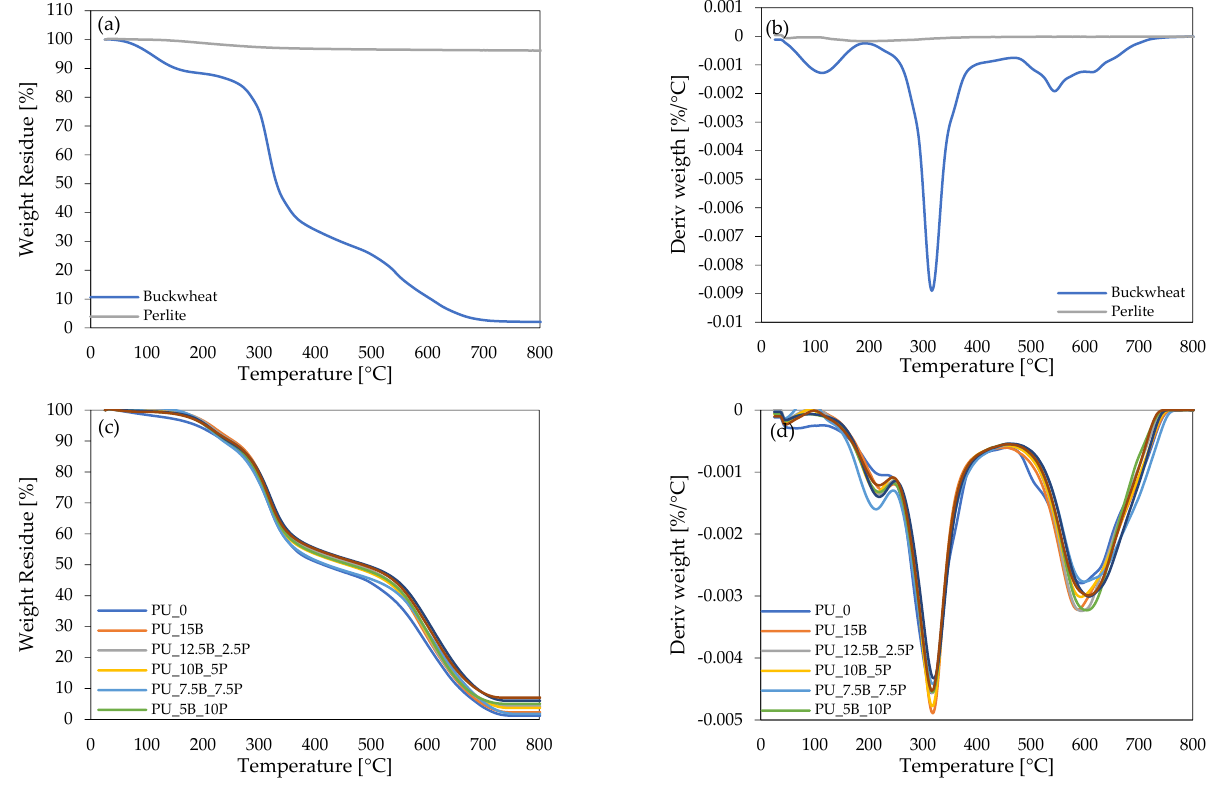
Figure 10. Thermogravimetric (TGA) and derivative thermogravimetry (DTG) results obtained for ( a , b ) buckwheat hulls and perlite fillers and ( c , d ) polyurethane composite foams. Table 3. The results of the thermogravimetric analysis of rigid PU